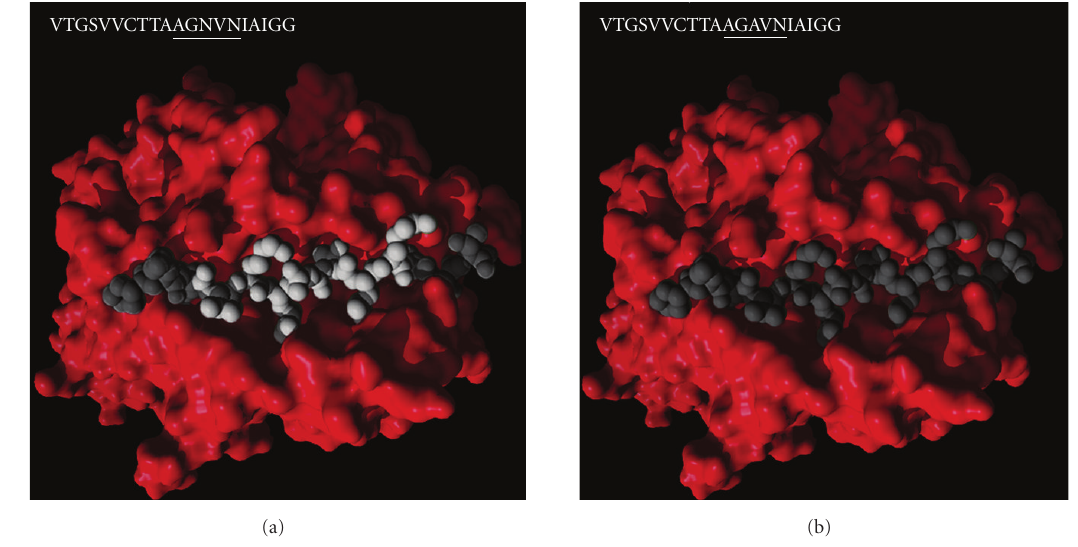
Figure 2: The immunogenic impact of a single amino acid substitution in the five core residues (AGNVN, aa 71–75) of the immunodom- inant p61–80/PT19 mycobacterial epitope (VTGSVVCTTAAGNVNIAIGG). The substitution of N73A impairs T immunogenicity for the target epitope and changes the proteomic similarity level of the five core residues (aa 71–75 underlined) from one match (aa sequence AGNVN) to eight matches (aa sequence AGAVN). (a) The immunogenic MHC-peptide complex containing the central low-similarity pentapeptide AGNVN (in white); (b) The nonimmunogenic MHC-peptide complex containing the higher similarity pentapeptide AGAVN (in gray). Immunoreactivity and mutagenesis experiments are described in [58]. The figures are modified versions of the original drawings from the website http://www.iayork.com/ by kind authorization of Professor Ian York, University of